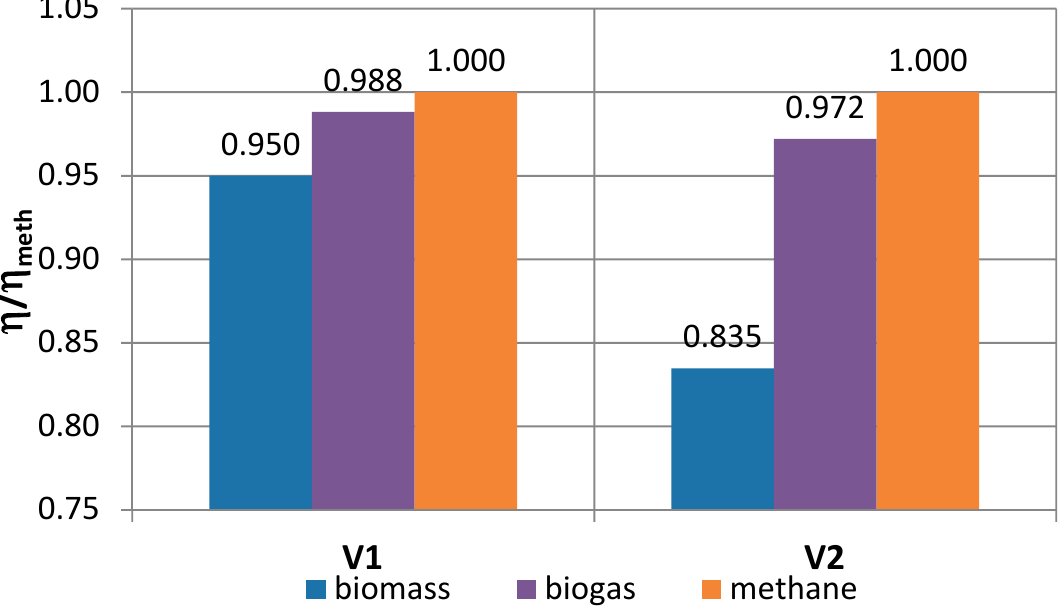
Figure 5. Influence of the structure of the cycle and calorific value of fuel on the optimal compression.